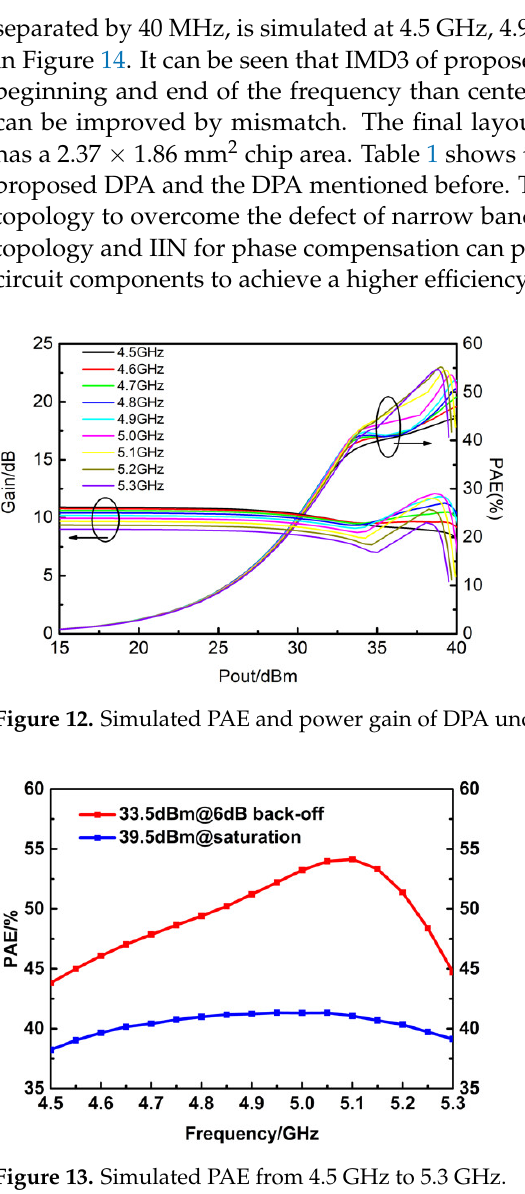
Table 1. Comparison of performance with other published DPA.